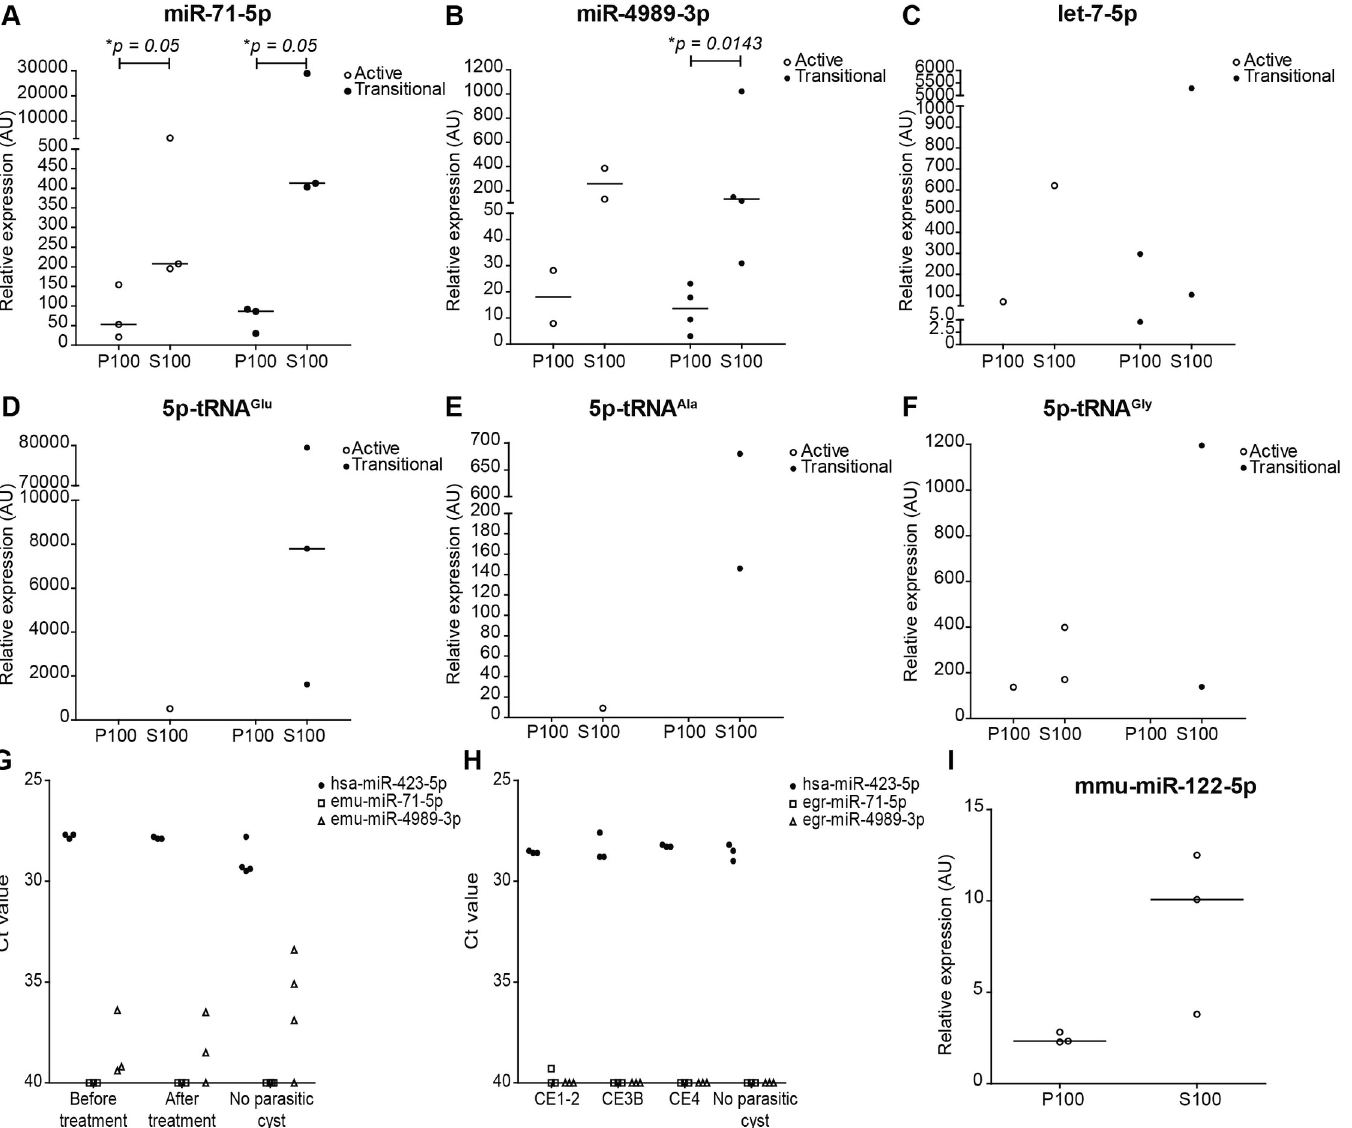
Fig 7. RT-qPCR detection of selected ex-RNAs in vitro and in vivo . A-F) Relative expression from selected miRNAs in culture medium from active and transitional cultures of E . multilocularis metacestodes is depicted in arbitrary units (AU). Values were normalised to input culture medium. Number of biological replicates tested for microRNAs: N Act = 3, N Trans = 4, and for tRNAs: N Act = 2, N Trans = 3. Assessment of detection of Echinococcus spp. microRNAs in serum/plasma samples from alveolar (G) and cystic (H) echinococcosis patients. Raw Ct values are shown. Ct = 40 means no amplification. I) Expression levels of vertebrate miR-122-5p in metacestode vesicular fluid from active cultures. Expression is based on RT-qPCR analysis of P100 and S100 fractions; values were normalized to input vesicular fluid. N = 3. Lines indicate the median values.